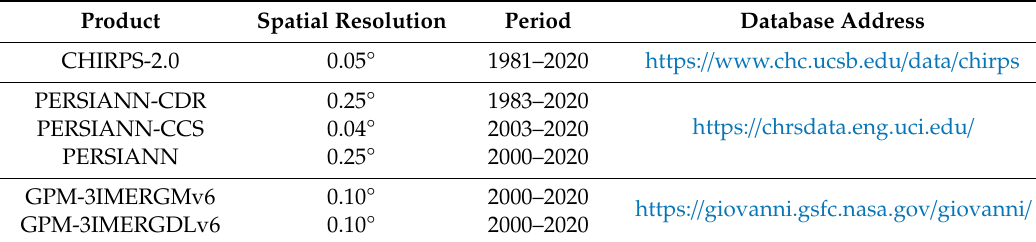
Table 2. Information related to rain estimations by remote sensing used in this